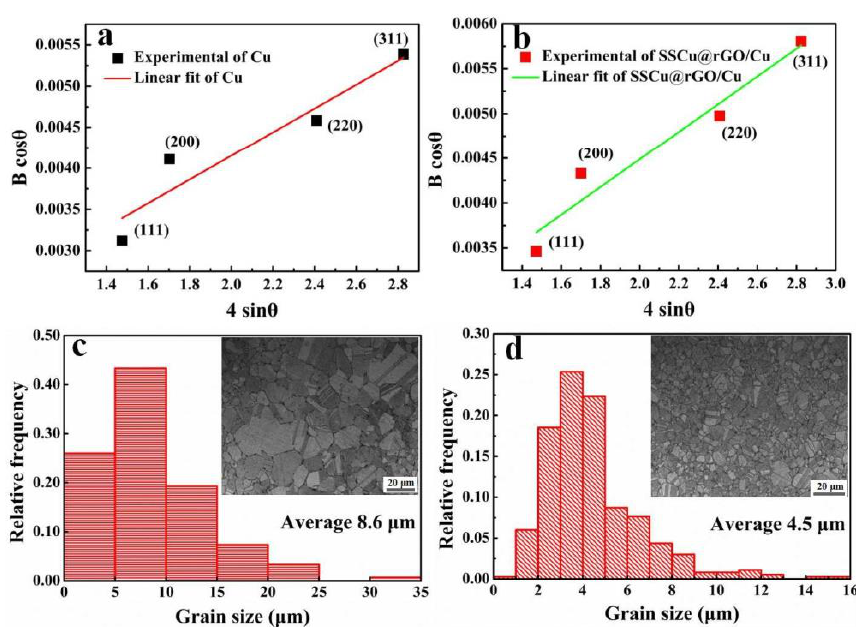
Figure 9. ( a , b ) are the linear fitting diagrams of B cos θ vs 4sin θ for Cu and the SSCu@rGO/Cu composites, respectively. ( c , d ) are the grain size statistics of Cu and the SSCu@rGO/Cu composites, respectively.